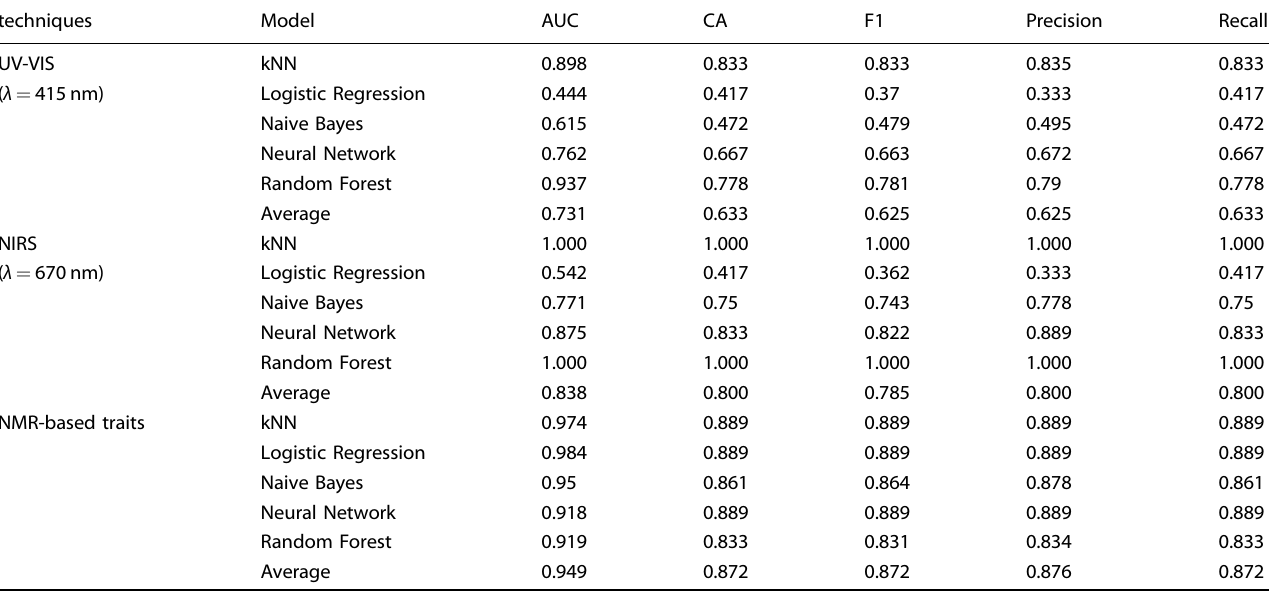
Table 1. Classi fi cation of olive oils using the Receiver Operating Characteristic analysis. techniques